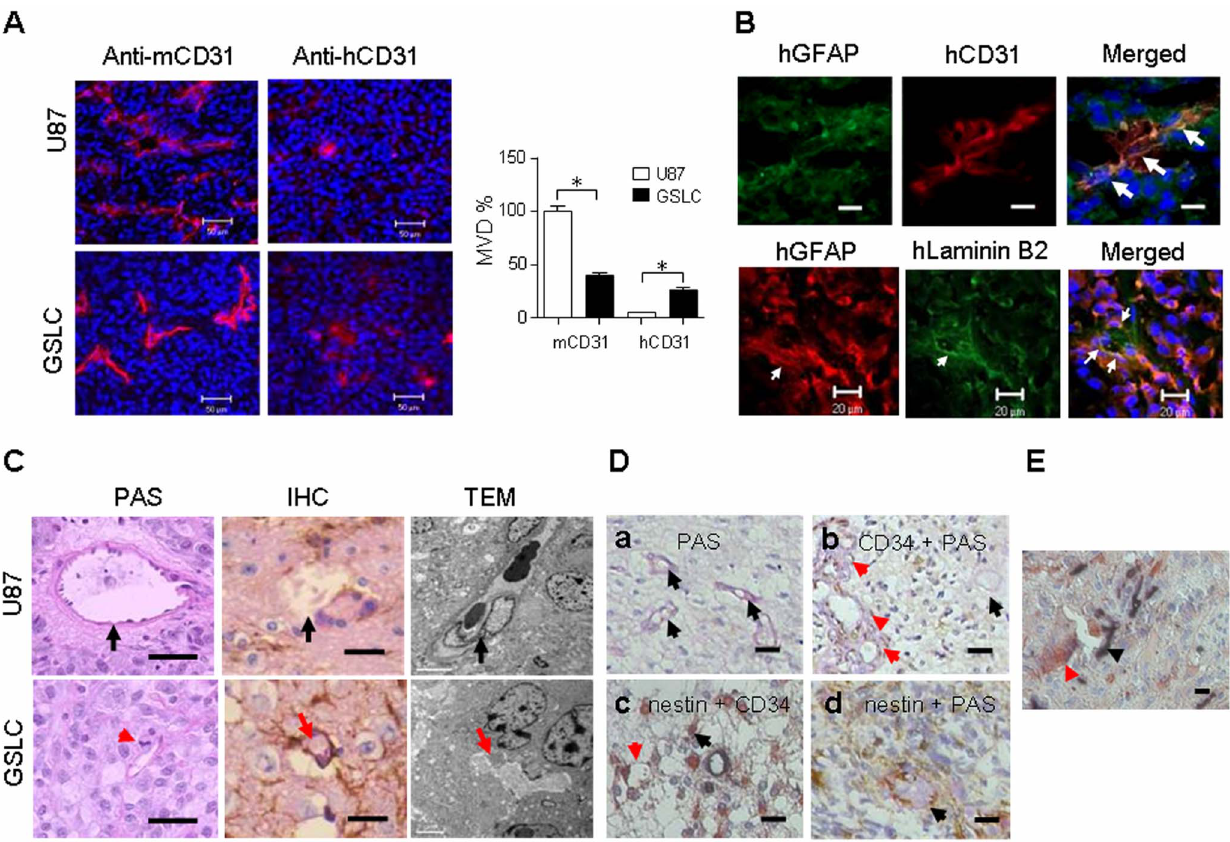
Figure 1. Vasculogenesis and VM in xenograft tumors derived from GSLCs and primary human glioma. ( A ) ECs detected with anti- human and anti-mouse CD31 antibodies in the tumors formed by U87 GBM cells ( top ) and GSLCs ( bottom ). Right panel shows quantification of human (h) and mouse (m) CD31 + cells. * Indicates statistically significant differences between tumors formed by U87 parent cells and GSLCs (* p , 0.01 ). Nuclei were counterstained by DAPI (blue). Scale bar=50 m m. ( B ) Double-immunofluorescence staining to detect human CD31 + (red) and GFAP + (green) ( top ) as well as human GFAP (red) and laminin B2 (green) ( bottom ) in GSLC-derived xenograft tumors. Nuclei were counterstained by DAPI (blue). Scale bar=20 m m. ( C ) PAS: Vascular basement membrane stained by PAS in xenograft tumor sections. Black arrow indicates blood vessel lined by ECs. Red arrow indicates VM lined by glioma cells with mitosis. Scale bar=50 m m. IHC: Double positive staining of nestin and PAS formed tubule including red cells in GSLC xenograft tumor section, but not in U87 xenograft tumor section. Black arrow indicates blood vessel lined by ECs which were PAS-positive reaction only in the basement membrane. Red arrow indicates VM lined by glioma cells positive in nestin. Scale bar=50 m m. TEM: Transmission electron microscopy of VM in GSLC initiated xenograft tumors. A vascular channel is lined by a thin basal lamina (red arrow) corresponding to the walls of the channel seen by conventional light microscopy. No endothelial cells line the tubule as compared to xenograft tumor formed by U87 cells (upper panel). Scale bar=5 m m. ( D ) ECs in a human GBM section detected by anti-CD34 (black color). Vascular basement membrane with PAS staining (purple magenta) and tumor cells are labeled with anti-nestin antibody (brown color). a , Black arrows show tubular blood vessels stained with PAS. b , Double-staining of CD34 and PAS shows vessels (red arrows); PAS-positive tubules are lined by CD34 2 cells (black arrow). c , Tumor vessels containing red blood cells are positive for nestin but negative for CD34 (red arrow). Black arrow shows CD34 + blood vessels. d , PAS positive tubules containing red blood cells are lined by nestin-positive cells on the luminal surface (black arrow). Scale bar=50 m m. ( E ) Tumor cell-lined vessels (red arrow) and EC-lined vessels (black arrow) are detected in the same tubule in a human GBM specimen. Scale bar=20 m m.